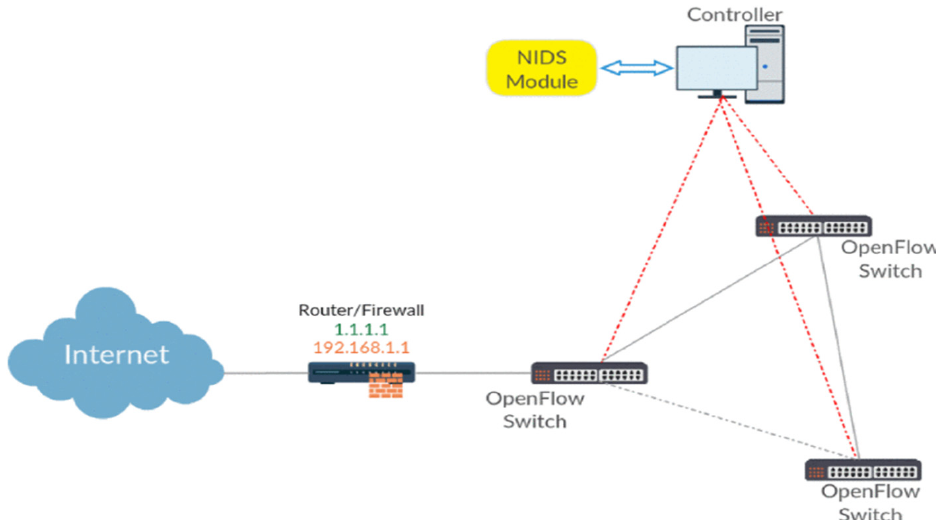
Table 10. SDN-related Features on the NSL-KDD dataset after feature